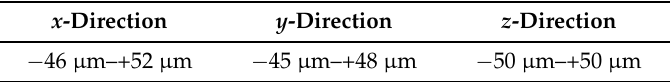
Table 4. Position errors due to a decentration of the total optics.